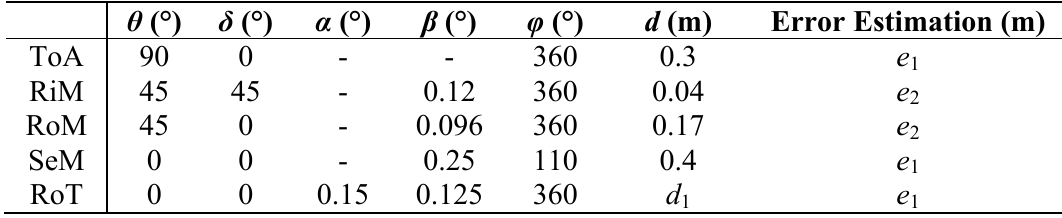
Table 3. Parametric specifications of the used laser scanning systems and the related tree-top capturing error